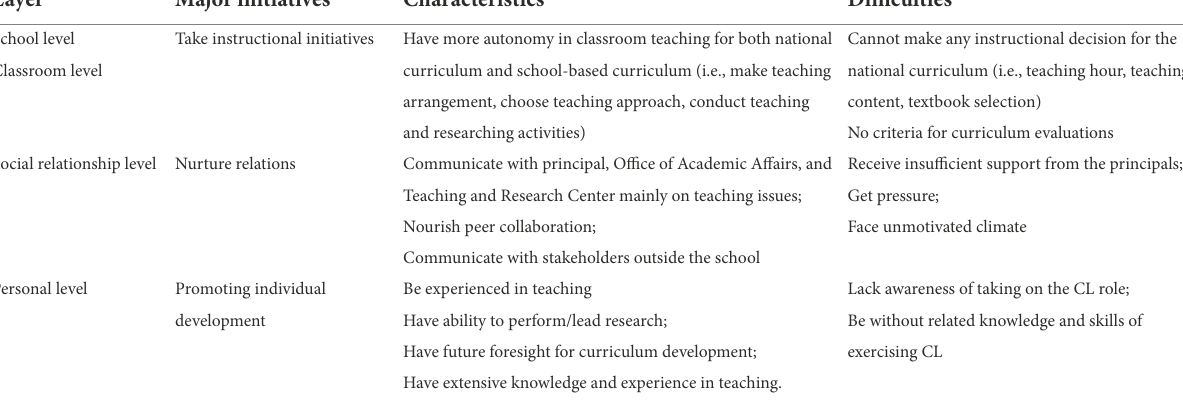
TABLE 4 Summary of findings related to TRG Leaders’ engagement in